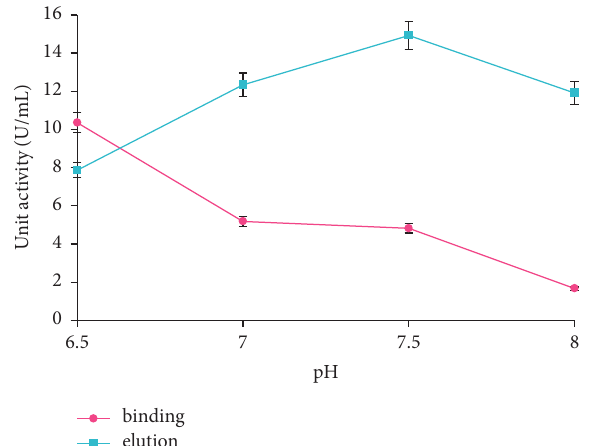
Figure 3: Binding buffer pH for enzyme immobilization. The data are presented as mean ± SD; n � 2; p ≤ 0 . 05. The error bars represent standard deviations from two replicates measurements.